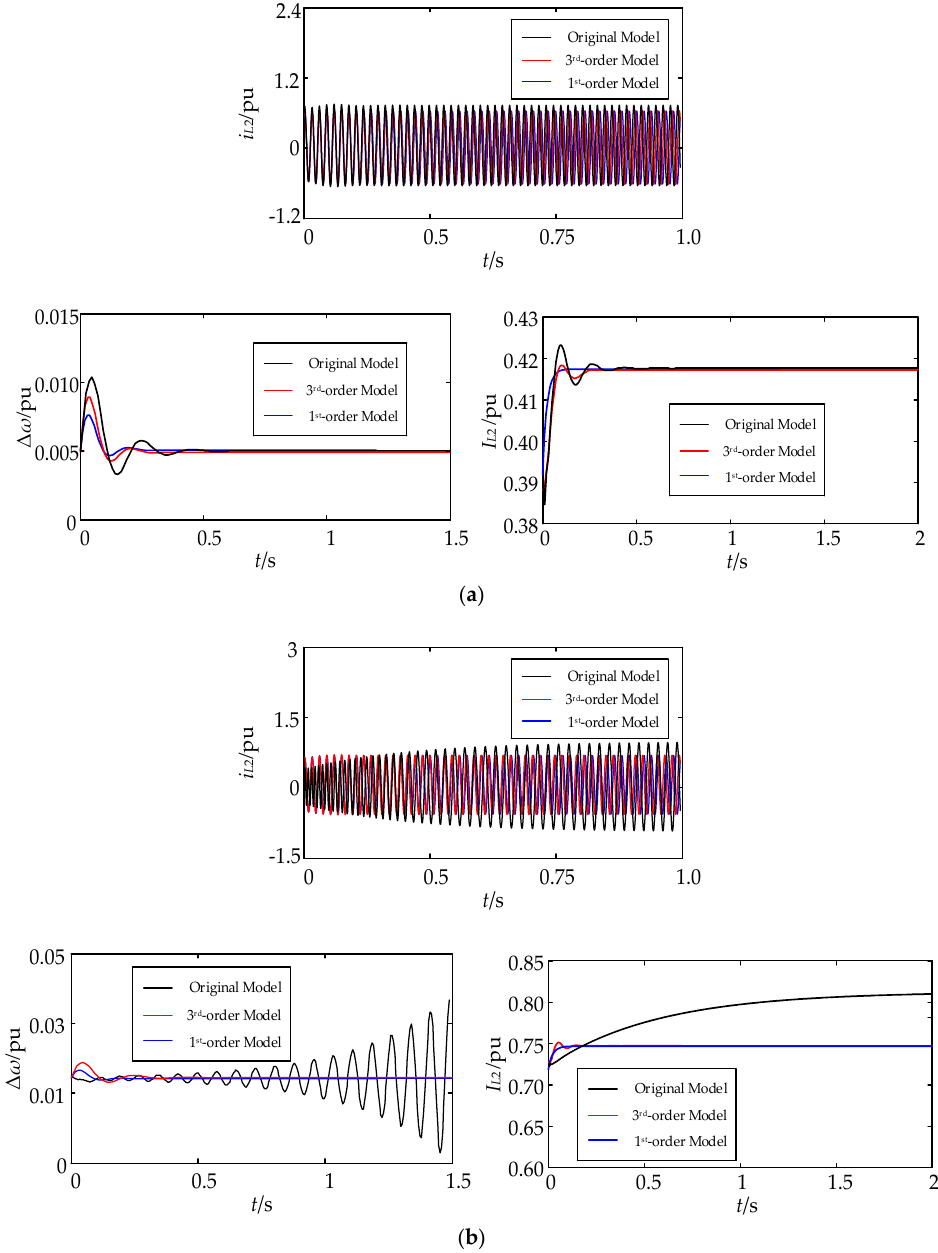
Figure 5. Simulation results of the test system 1: ( a ) at the stable point; ( b ) at the unstable point. Table 5. Consistency indexes of dynamic response for reduction models in stand-alone system.